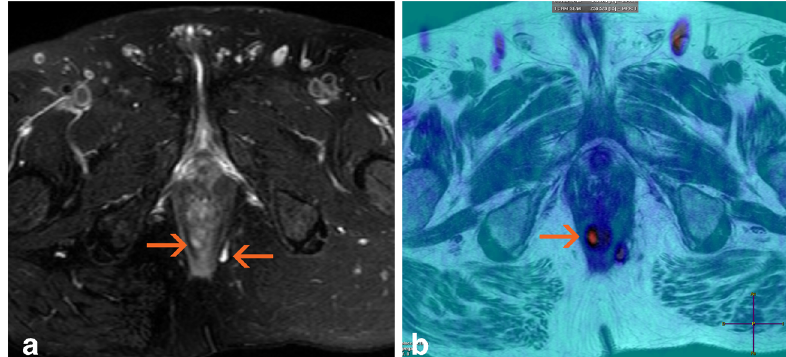
Fig. 10 Oblique-transverse T2- weighted image ( a ) and merged view of a colour-coded map derived from an 800 s/mm 2 b factor and a T2-weighted image ( b ). Right intersphinteric path (arrow) is clearly more conspicuous in image